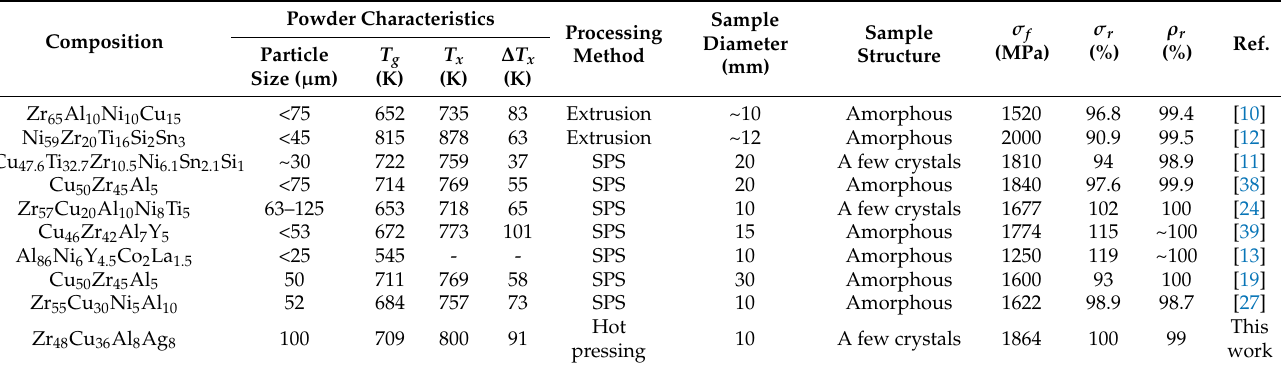
Table 3. Microstructural features and mechanical properties of BMGs synthesized by powder metallurgy. σ f is the fracture strength, σ r is the relative strength with respect to the cast counterpart ( σ r = σ f / σ cast × 100%, where σ cast is the fracture strength of the cast BMG with same composition), and ρ r is the relative density. T g = glass transition temperature, T x = crystallization temperature, and ∆ T x = supercooled liquid